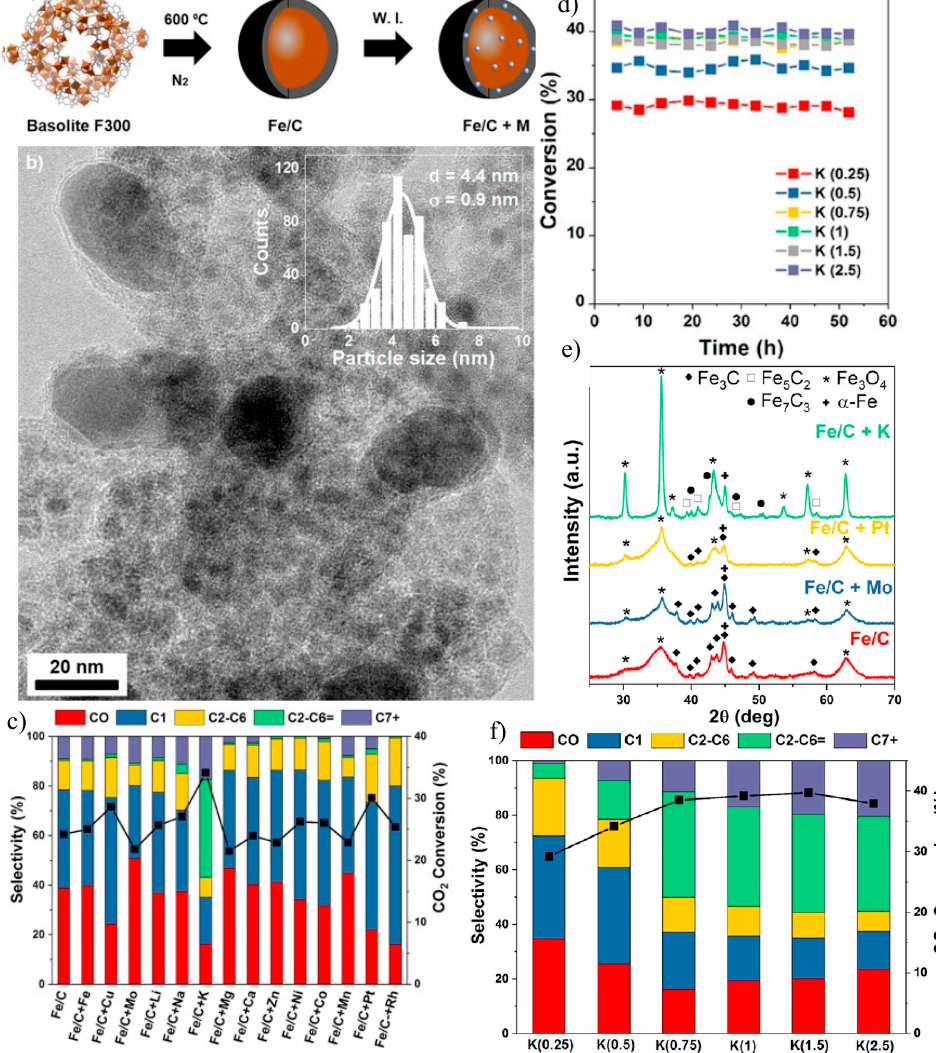
Figure 8. ( a ) Illustrated synthesis of Fe/C catalysts. ( b ) TEM image of Fe/C catalysts. ( c ) Catalytic performance over promoted and unpromoted Fe catalysts. ( d ) CO 2 conversion after 50 h of TOS. ( e ) XRD of promoted and unpromoted Fe catalysts. ( f ) Effect of K loading on the selectivity and CO 2 conversion after 50 h of TOS. Testing conditions: 593 K, 30 bar, H 2 /CO 2 molar ratio = 3, and GHSV = 24,000 mL·g − 1 ·h − 1 . Adapted with permission from ref. [99]. Copyright 2018 American Chemical Society.